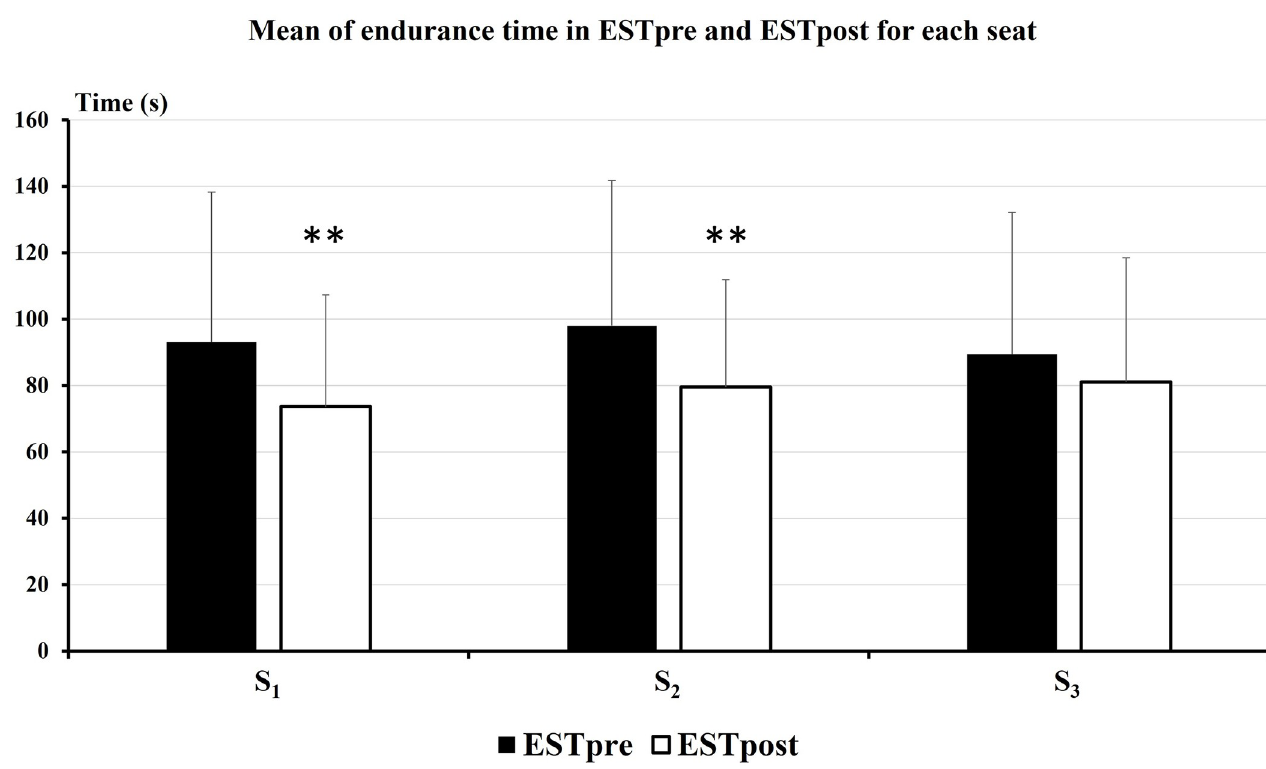
Fig 3. Endurance time mean (in seconds) of ESTpre and ESTpost driving session for the three tested seats. Significant differences between endurance time measured before and after driving session are illustrated by � (p < 0.001).